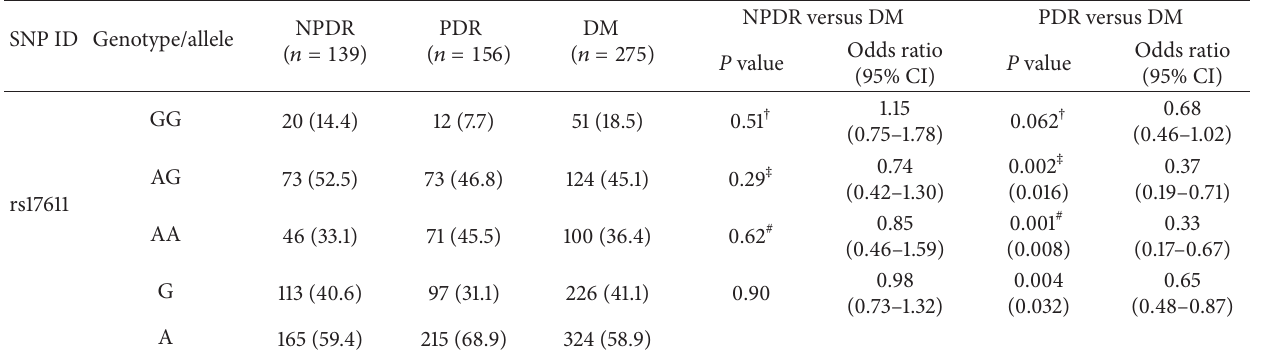
Table 3: Comparison of genotype and allele frequency of C5 -rs17611 in DR and DM stratified by disease severity. SNP ID Genotype/allele